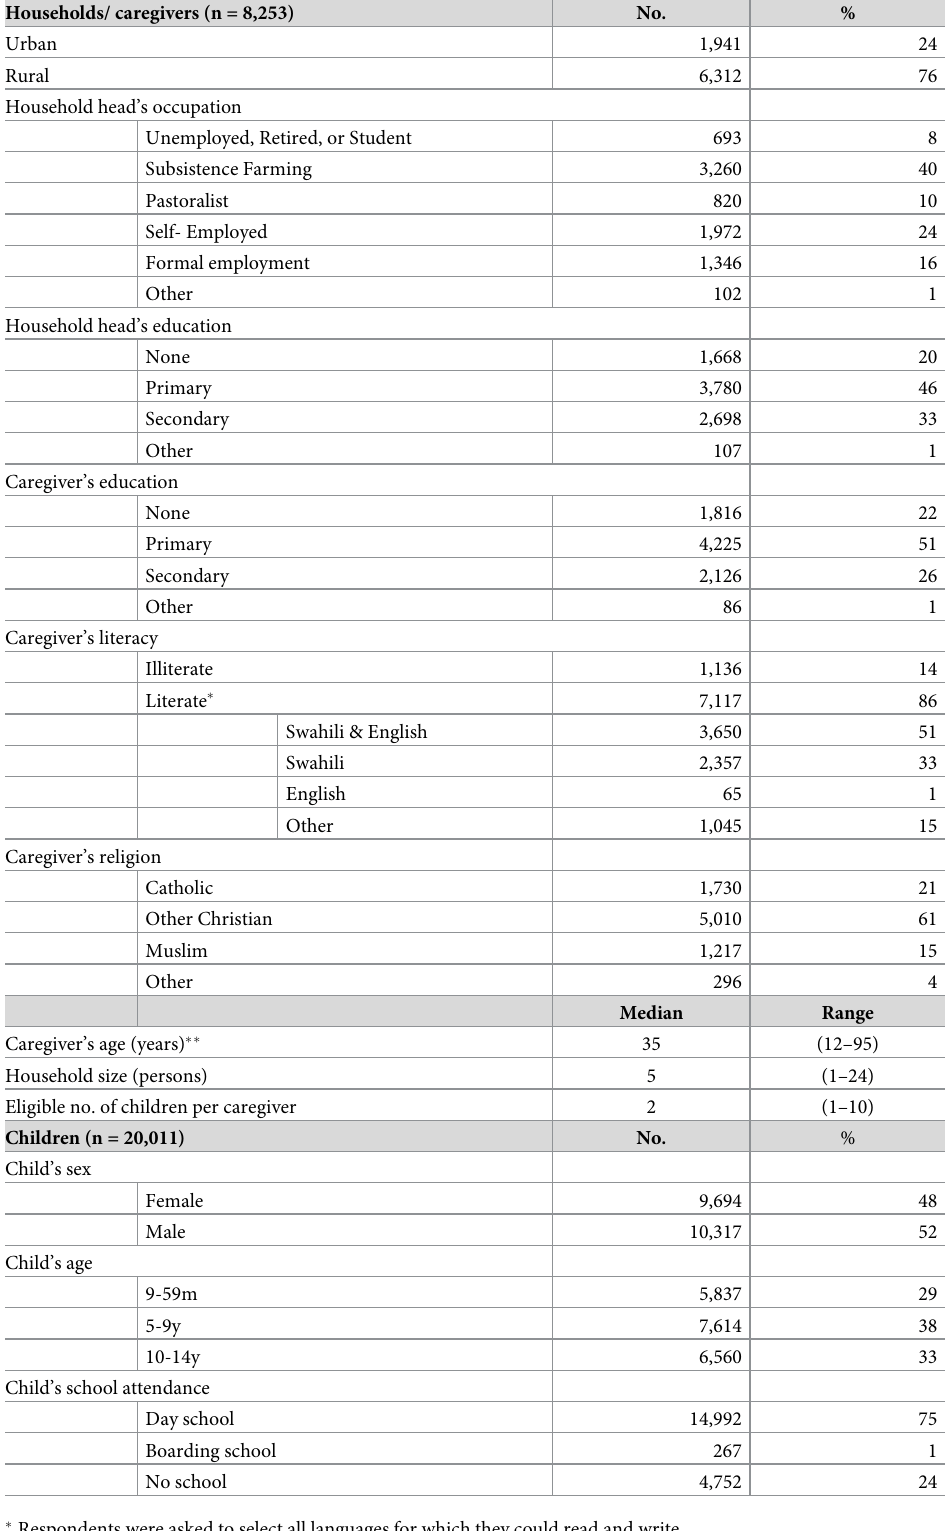
Table 1. Socio-demographic characteristics of respondents in the measles-rubella vaccination coverage survey— Kenya, 2016. Households/ caregivers (n = 8,253) No. % Urban Rural Household head’s